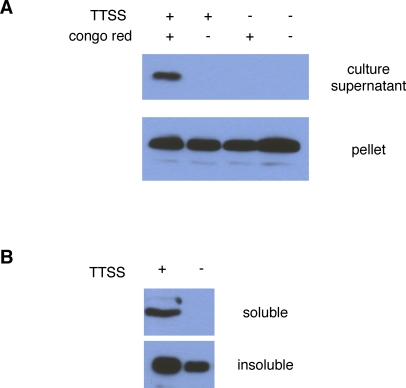
IpaJ Secretion and Translocation Are Dependent on an Intact Type III Secretion System(A) Wild-type and BS547 (mxiM1) [50] Shigella, a TTSS-defective strain, that carry a low-copy number plasmid that expresses IpaJ-FLAG from its endogenous promotor were grown in the presence of Congo Red, an inducer of the Shigella TTSS. Proteins from culture supernatants and whole-cells were separated by SDS-PAGE and subjected to western blot analyses with anti-FLAG antibody.(B) HeLa cells were infected with either wild-type or BS547 (mxiM1) Shigella that express IpaJ-FLAG at an MOI of 100:1. One hour after infection, the cells were lysed and fractionated into soluble and insoluble fractions. Proteins from each fraction were separated by SDS-PAGE and subjected to western blot analyses with anti-FLAG antibody. Translocated proteins are found in the soluble fraction, while those from unlysed bacteria are found in the insoluble fraction.